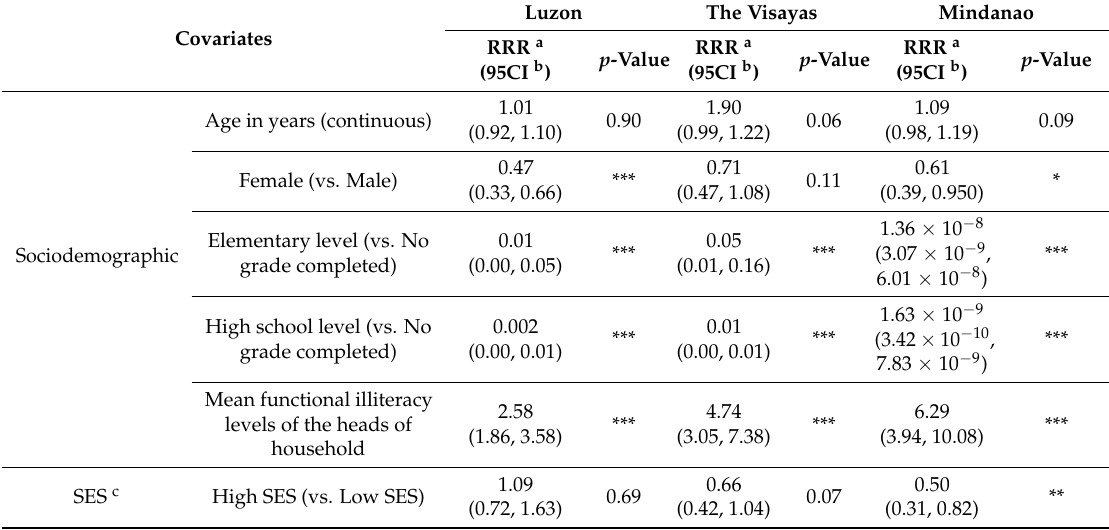
Table 3. Association of selected covariates with functional illiteracy in school-aged children in the Philippines.